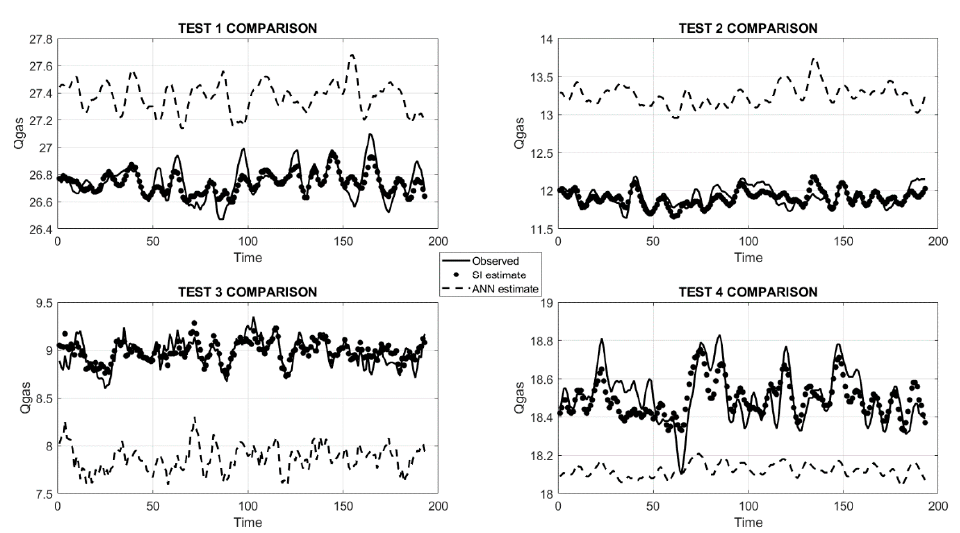
Figure 10. Comparison of estimates obtained with the neural network and the Grey Wolf models for